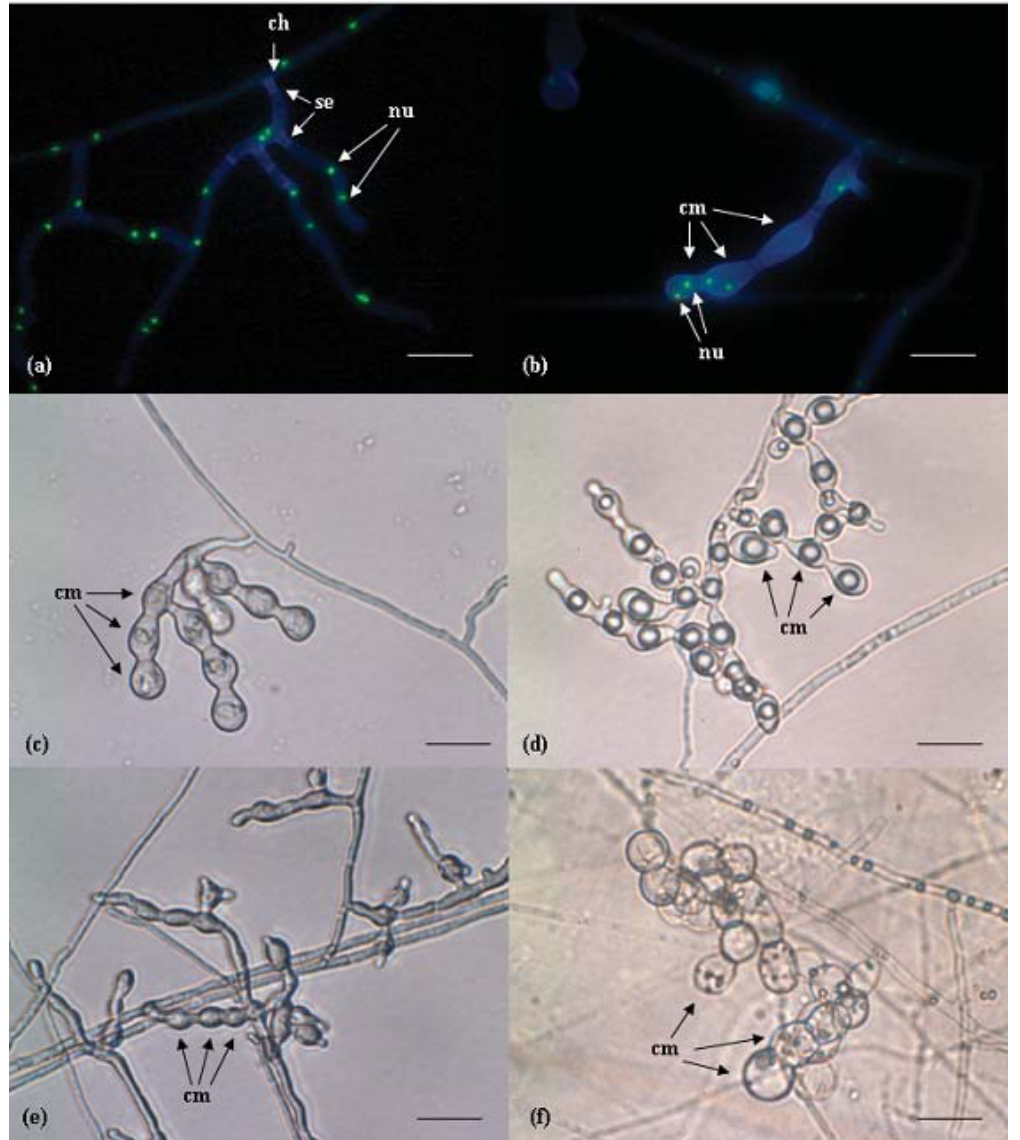
Figura 1. Hifas vegetativas e células monilioides de fungos rizoctonioides, isolados de Epidendrum secundum em quatro diferentes localidades, cultivados durante uma semana em microcultura para posterior tratamento com os cromóforos SYBER GREEN I ® e Calcofluor e observação em microscopia de fluorescência (a-b). Células monilioides, observadas em microscopia de luz, formadas pelos isolados após, pelo menos, dois meses de cultivo em placas contendo meio CMA (c-f). (a) Isolado M55, mostrando ramificação da hifa em ângulo reto com constrição (ch) na altura dos septos (se), dois núcleos (nu) na célula da extremidade da hifa e delimitados pelos septos. (b) Células monilioides (cm) do isolado M66 apresentando dois núcleos por célula. Células monilioides dos isolados: (c) M53, ovaladas com depressões formando cadeias com duas a seis células; (d) M61, pequenas, hialinas e desuniformes ao longo da cadeia; (e) M70, pequenas, em cadeias de uma a oito células, opacas, com leve constrição entre as células; e (f) M76, grandes, esféricas e em cadeias de duas a quatro células. Barra = 20 μ